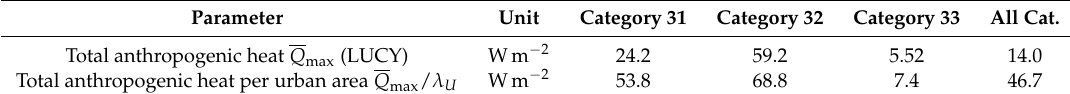
Table 7. Maximum values of total anthropogenic heat emissions disaggregated by urban category.